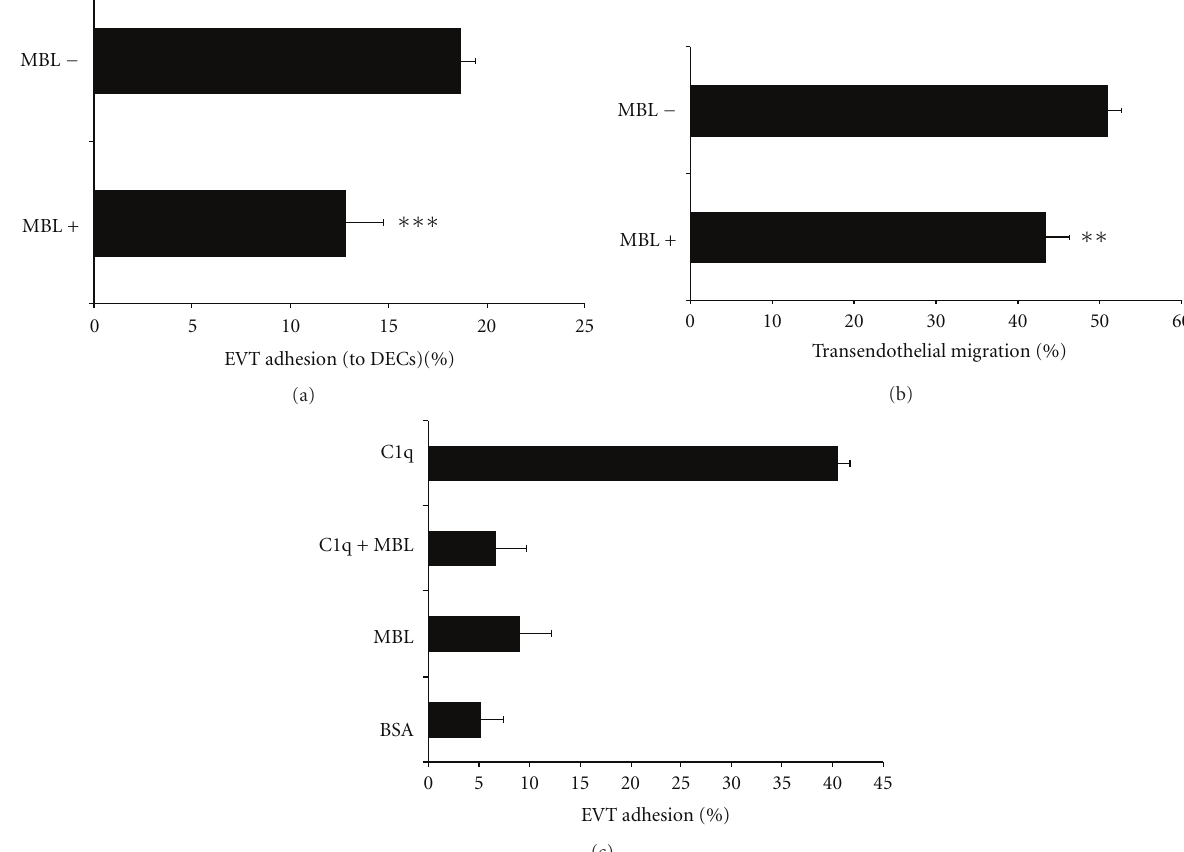
Figure 4: Analysis of MBL e ff ect in the interaction between EVTs to DECs. To investigate the e ff ect of MBL in the interaction between EVTs and DECs we performed adhesion (a) and migration assays through DECs, (b) in the presence of 2 µ g/mL of MBL. The graph in (c) confirm the ability of EVT to adhere to C1q, while MBL was not able to promote adhesion of EVT as compared to BSA used as negative control. The ability of MBL to inhibit the adhesion process was also evaluated on the binding of EVT to C1q (C1q + MBL). ∗∗ P < 0 . 01; ∗∗∗ P < 0 . 001; § P < 0 .